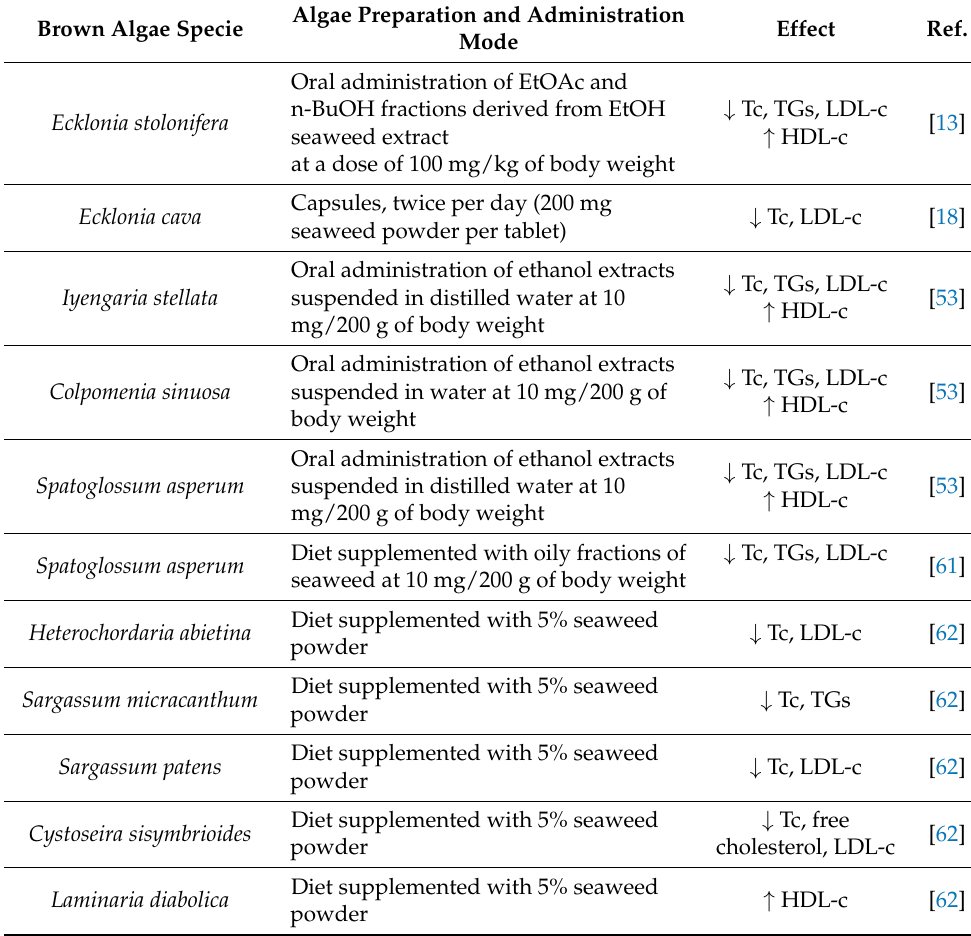
Table 2. Overview of the in vivo hypocholesterolemic effect of different brown algae species under different extraction